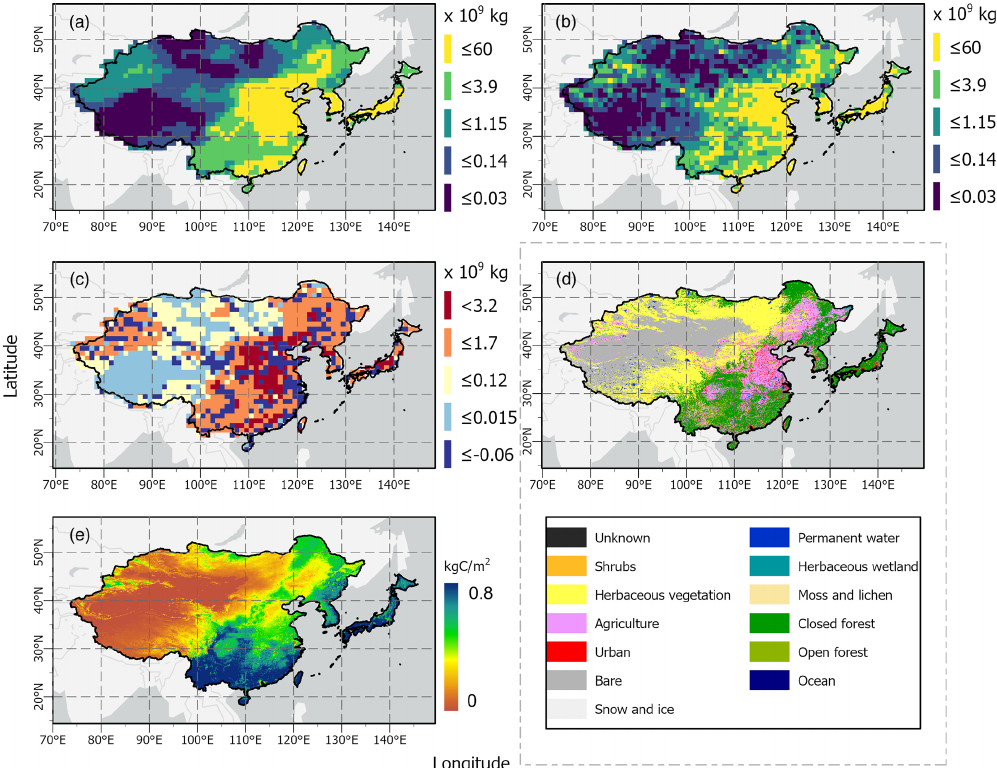
Figure 4. Spatial distribution of (a) OCO-2 XCO 2 -based anthropogenic CO 2 emission estimates for 2019, (b) actual ODIAC emissions for 2019, (c) their difference (estimated emission minus actual emission), (d) 100m resolution land cover distribution provided by the Copernicus Global Land Service over East Asia, and (e) the spatial distribution of NPP. (The base map was sourced from